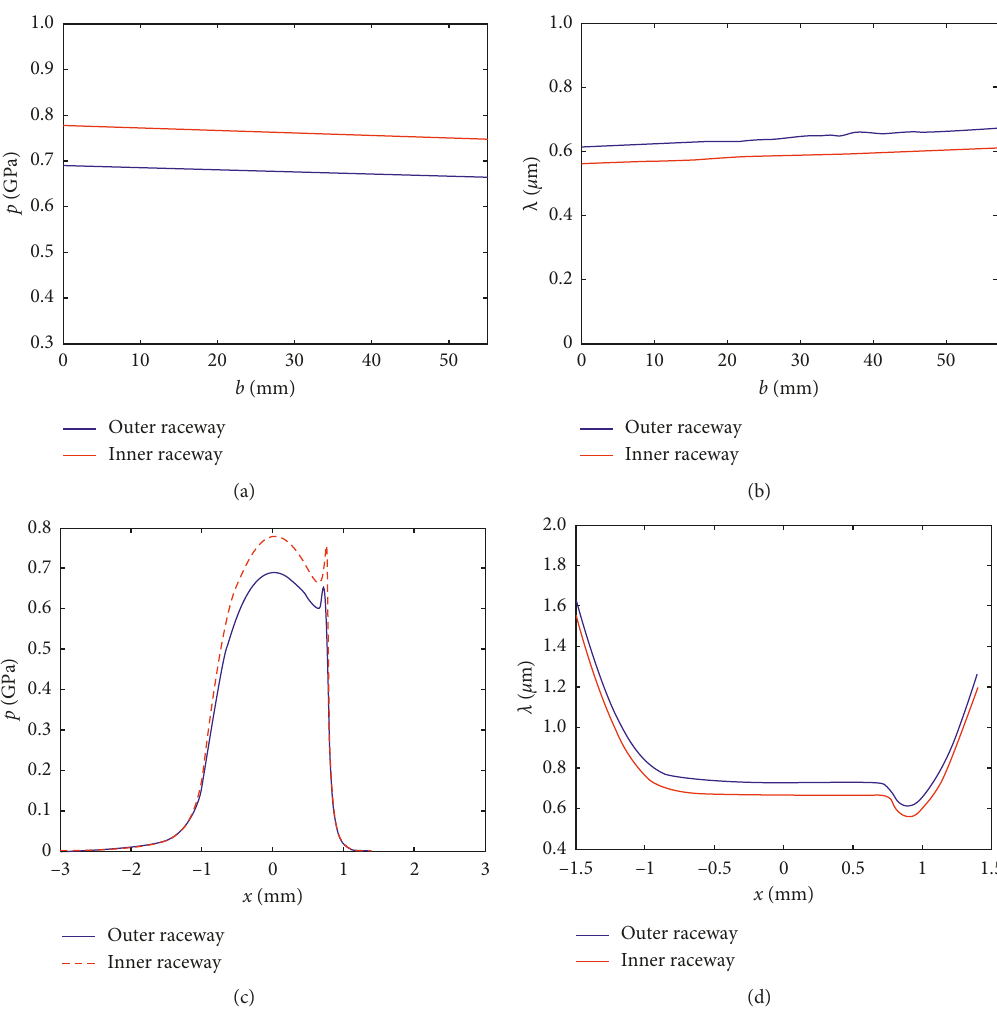
Figure 11: Distribution of film pressure and thickness along the roller generatrix under inner and outer contact conditions: distribution of (a) film pressure along the surface generatrices; (b) film thickness along the surface generatrices; (c) film pressure at the cross section; (d) film thickness at the cross